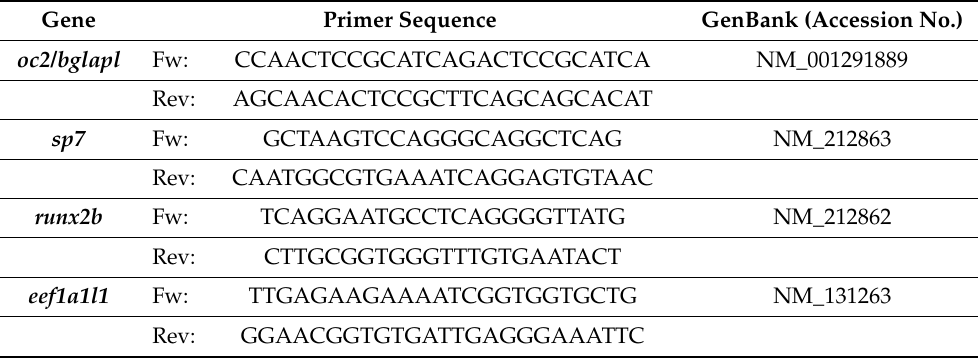
Table 1. Sequences of primers used. All sequences in 5 (cid:48) –3 (cid:48)